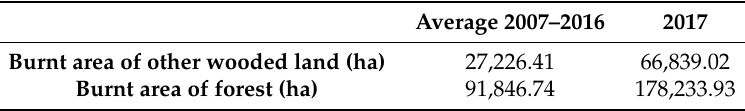
Table 2. Burnt area in 2017 compared with the 10 year average [5].